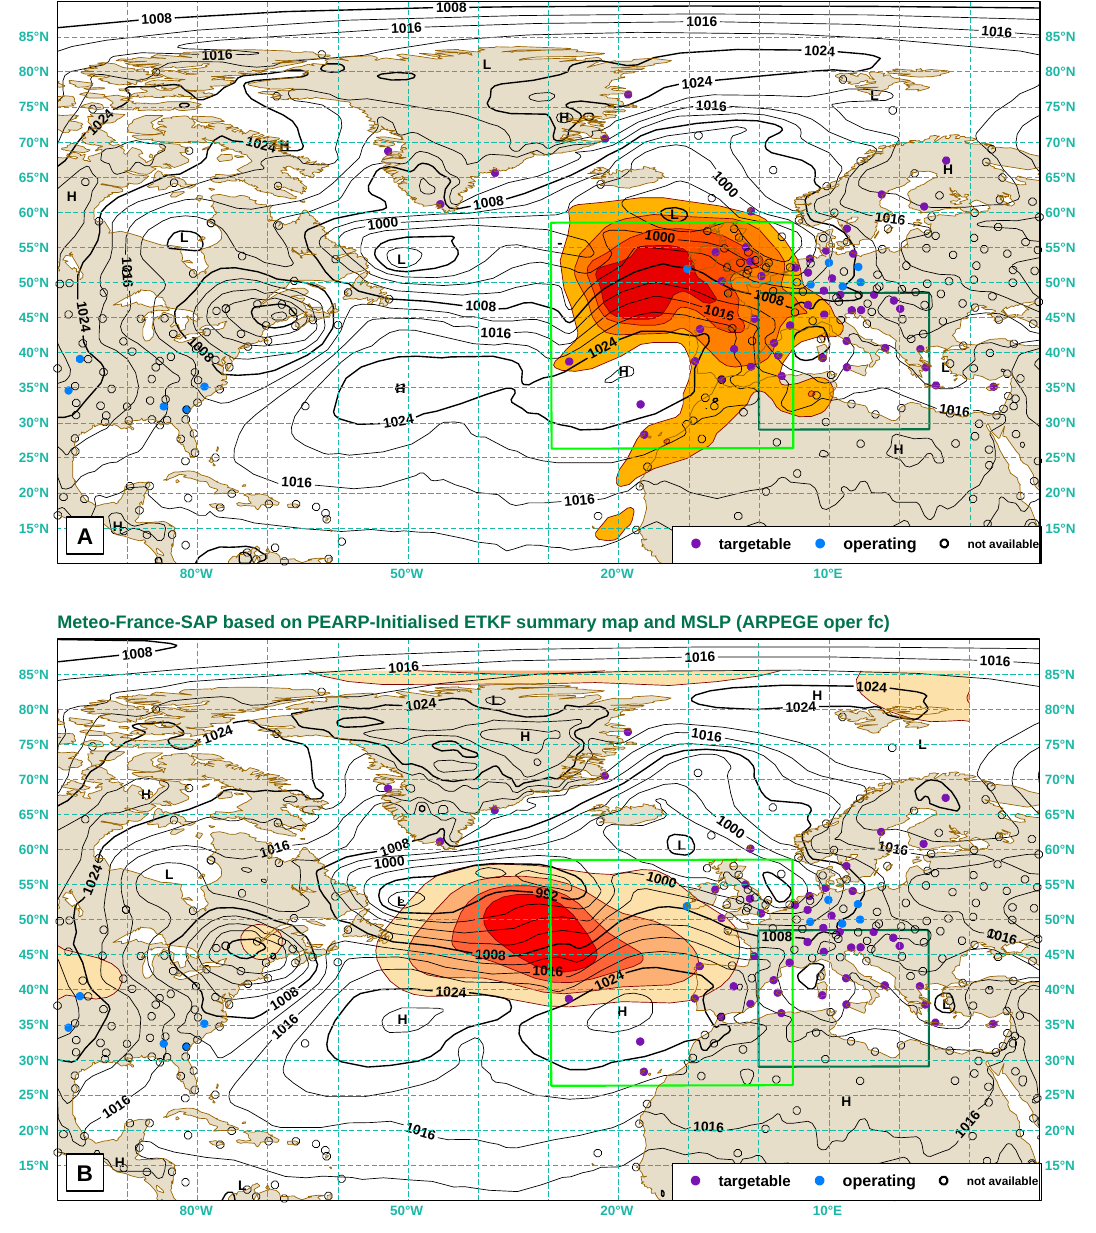
Fig. 2a. Example of fields for targeting guidance (FTG) corresponding to the case number 1120 of the DTS-MEDEX-2009 campaign. Each frame contains a sensitive area (shadings) overlaid with a predicted mean-sea level pressure (MSLP) field to allow some meteorological interpretation. The radio-soundings sites are plotted in violet when targetable, in blue when operating or with a circle when not available for targeting at observation time (TT). The dark green (small) box over the western Mediterranean basin delineate the verification area (VA) valid at verification time (VT). The clear green (large) over western Europe and eastern Atlantic delineate the observation request area. The case has been evaluated on 2 December 2009 (based on the analysis at 00:00 UTC). The lead-time is 42h, so targeting time is on 3 December 2009 at 18:00 UTC. The targeting guidance (these maps) is valid for that date. Thus, the MSLP fields are 42h forecasts. The verification time is on 5 December 2009 at 00:00 UTC. So the meteorological threat was evaluated on 72h forecasts. Frame A (upper) shows FTG based on the ECMWF total energy moist-TL95 singular vectors. This FTG was displayed in real time on the DTS web pages. Frame B (lower) is the FTG based on the M´et´eo-France ETKF. The ensemble prediction system used is PEArp (ARPEGE ensemble prediction system). The MSLP is the ARPEGE deterministic operational forecast. This FTG was displayed in real time on the DTS web